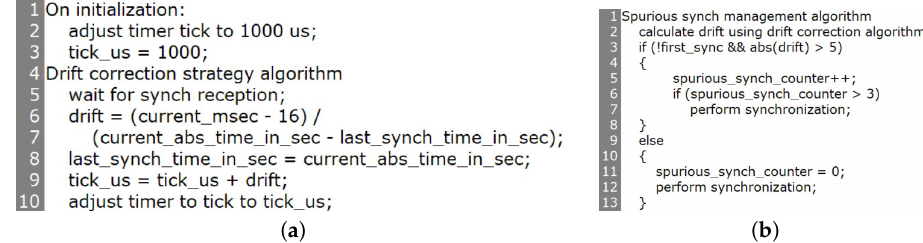
Figure 10. Algorithms used in Event Detection Nodes (EDNs). ( a ) Drift correction algorithm. ( b ) Spurious synch management